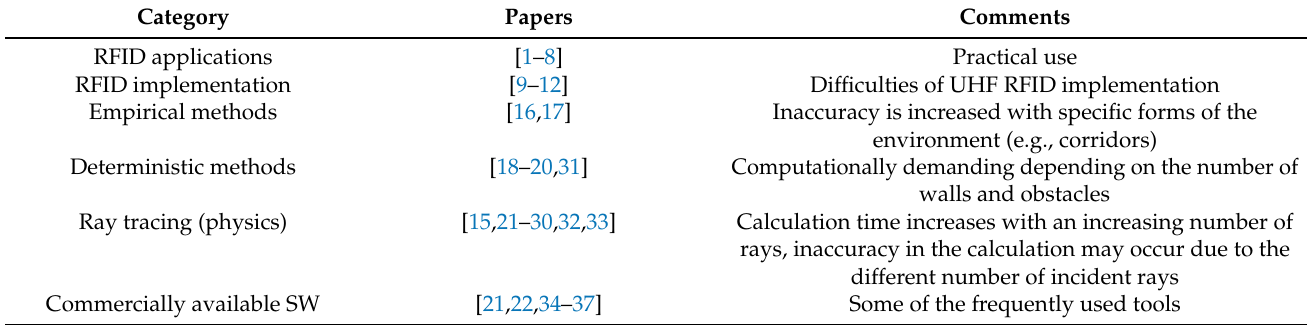
Table 1. Categories of